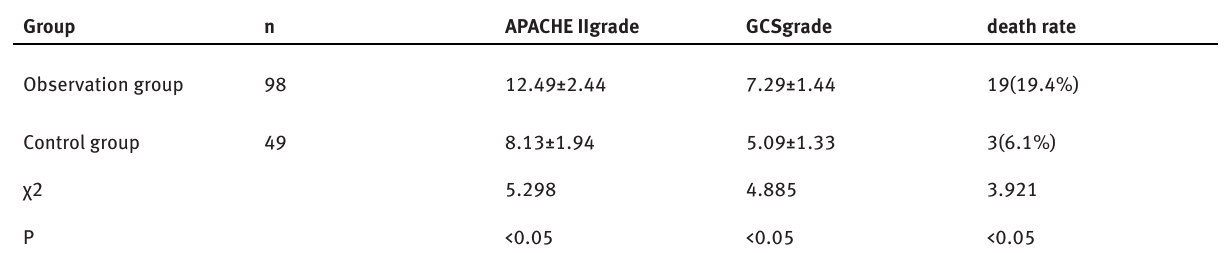
Table 4: Comparison of prognosis in both groups